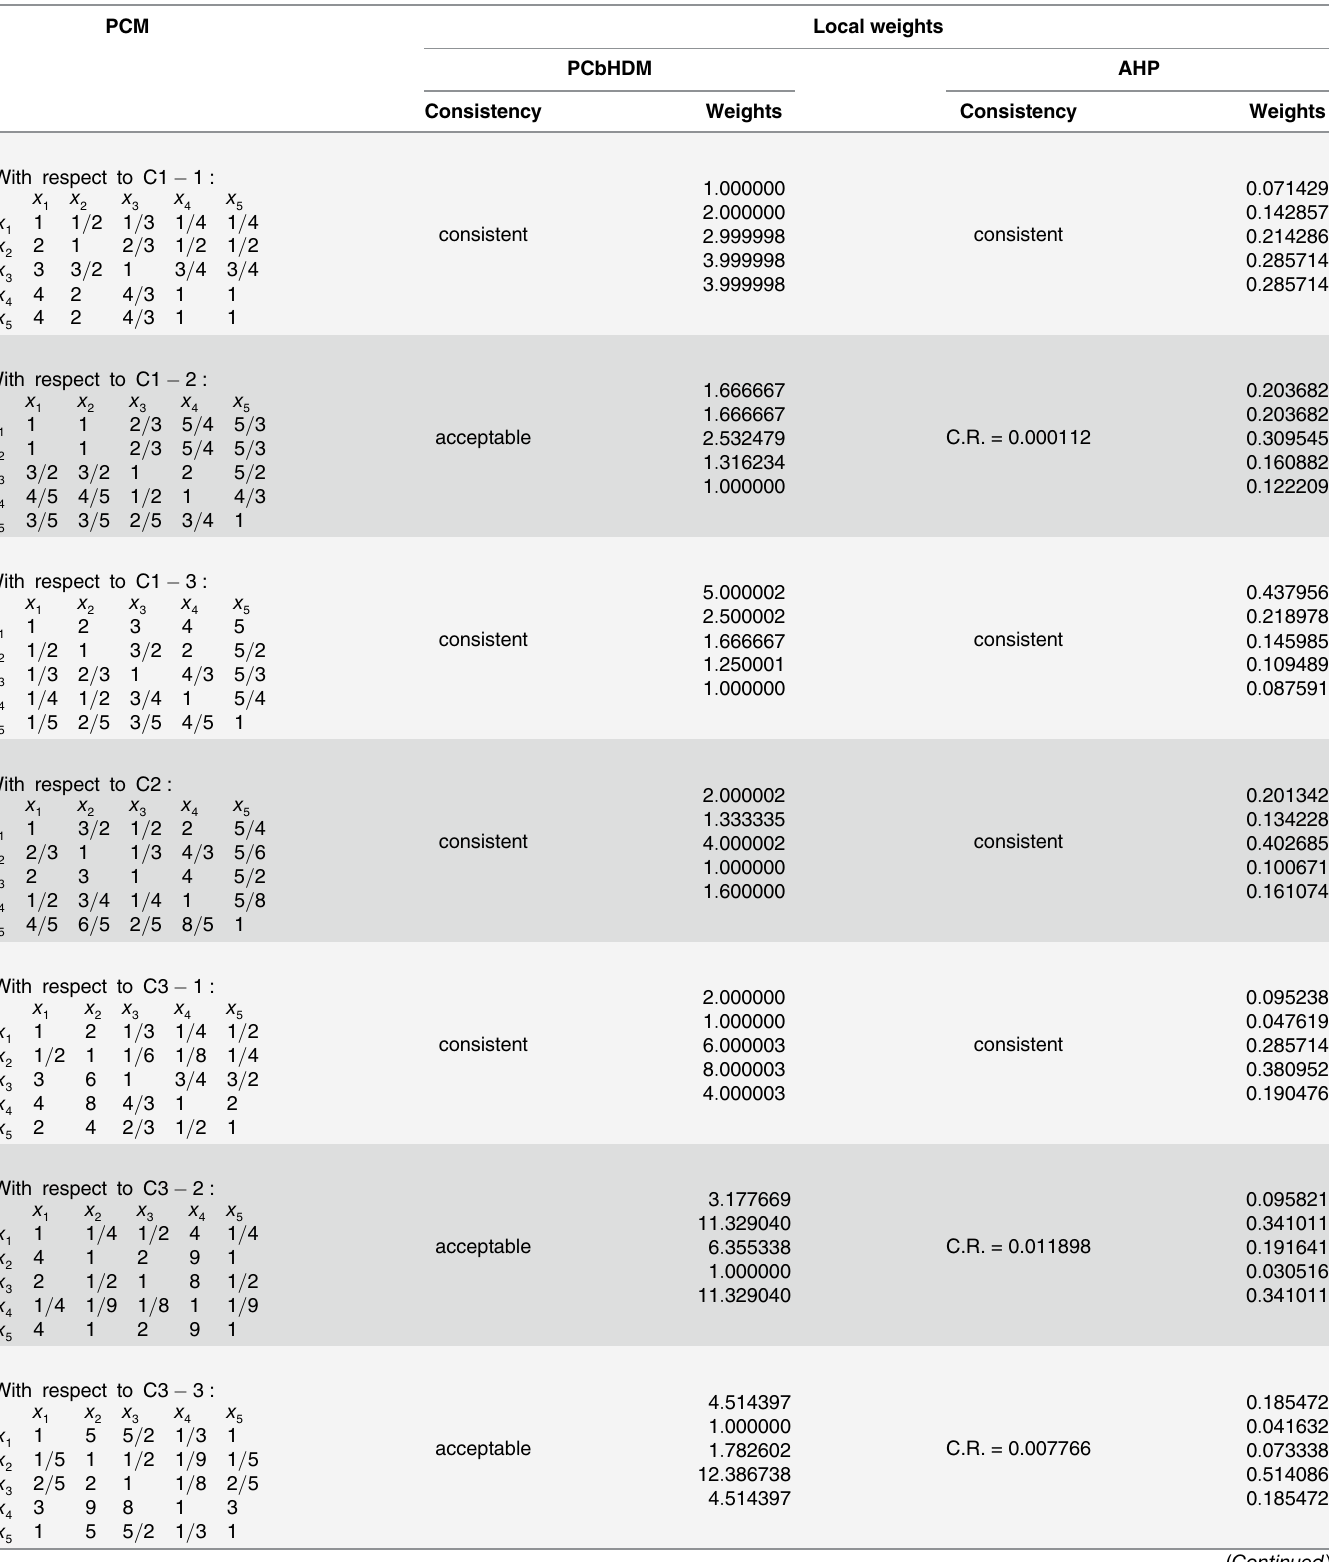
Table 4. PCMs of alternatives with respect to terminal criteria and local weights. PCM Local weights PCbHDM AHP Consistency Weights Consistency Weights